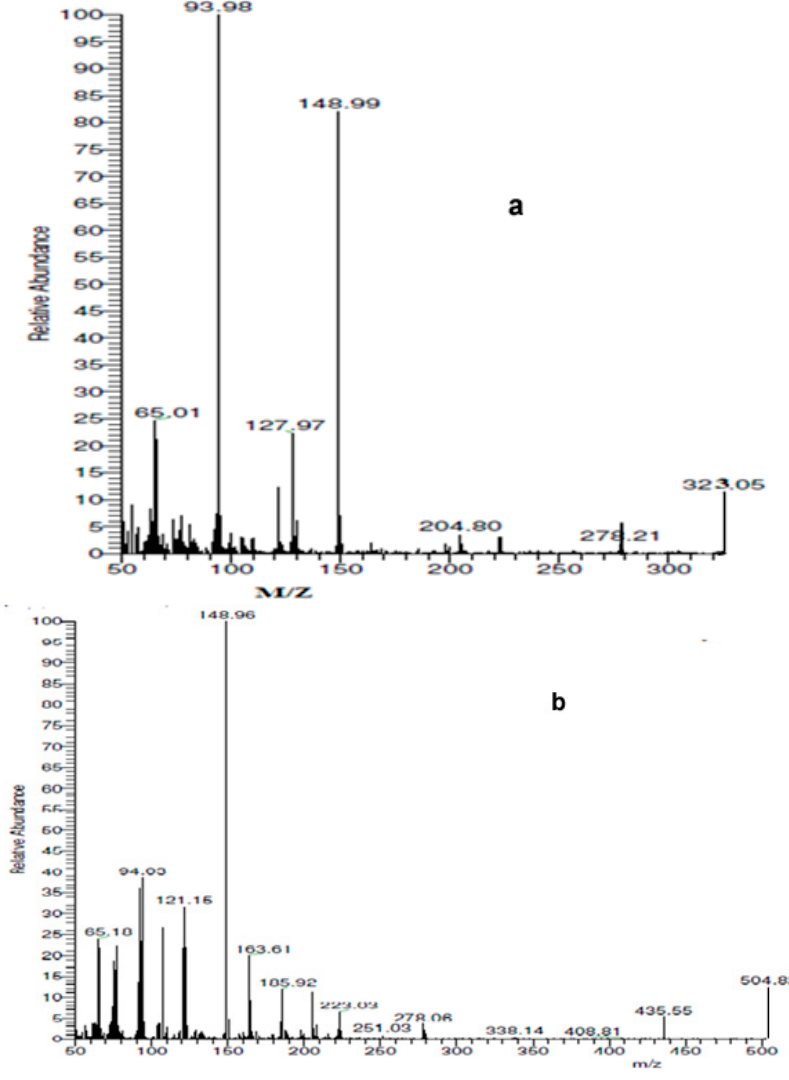
Figure 2. Mass spectra of ( a ) azo dye ligand (L), ( b ) Cd L complex.